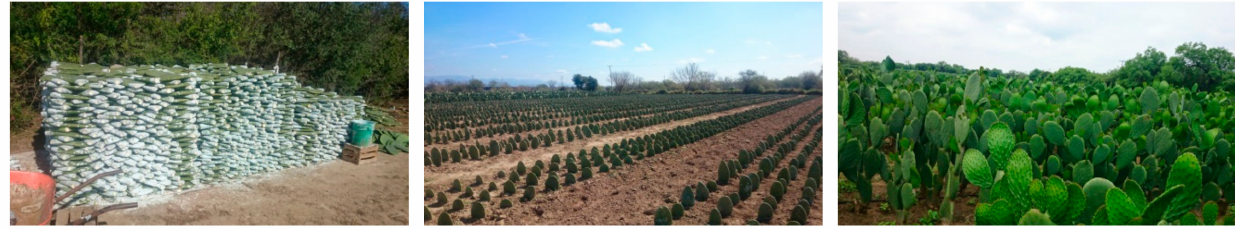
Figure 2. Planting and harvesting preparation of organic vegetable